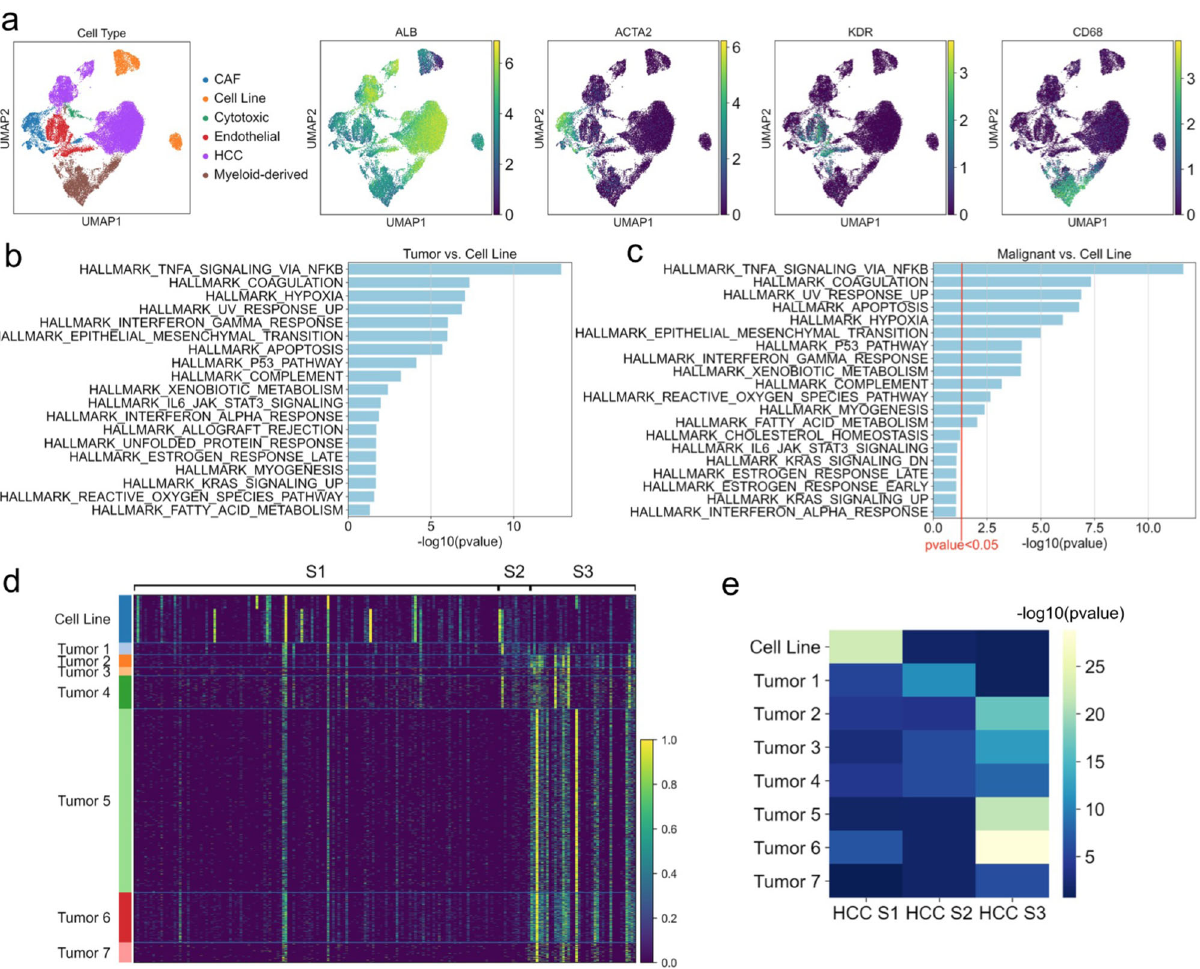
Fig. 5 Single-cell RNA sequencing analysis of hepatocellular carcinoma tumor samples and cell lines. a Single-cell RNA sequencing data clustering of hepatocellular carcinoma (HCC) cell line and tumor cells. b Gene set enrichment analysis of genes differentially overexpressed in all HCC tumor cells compared to HCC cell-line cells ( P value < 0.05). c Gene set enrichment analysis of genes differentially overexpressed in only malignant HCC tumor cells compared to HCC cell-line cells ( P value < 0.1, red line denotes P value < 0.05 cutoff). d Heatmap showing relative expression of genes from HCC molecular subtype gene signatures, in HCC cell line and tumor single-cell samples. e Heatmap showing − log10 P values for enrichment of differentially expressed genes in each HCC sample overlapping with the gene signatures for each HCC molecular